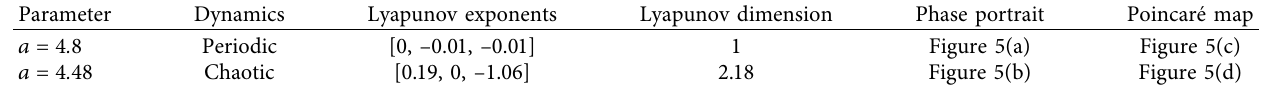
Table 3: Dynamics of system (1) for different parameter a with b � 9 . 5 ,c � 1 , and e � 1 and initial values [ 0 , 3 . 9 , − 0 . 7 ] . Parameter